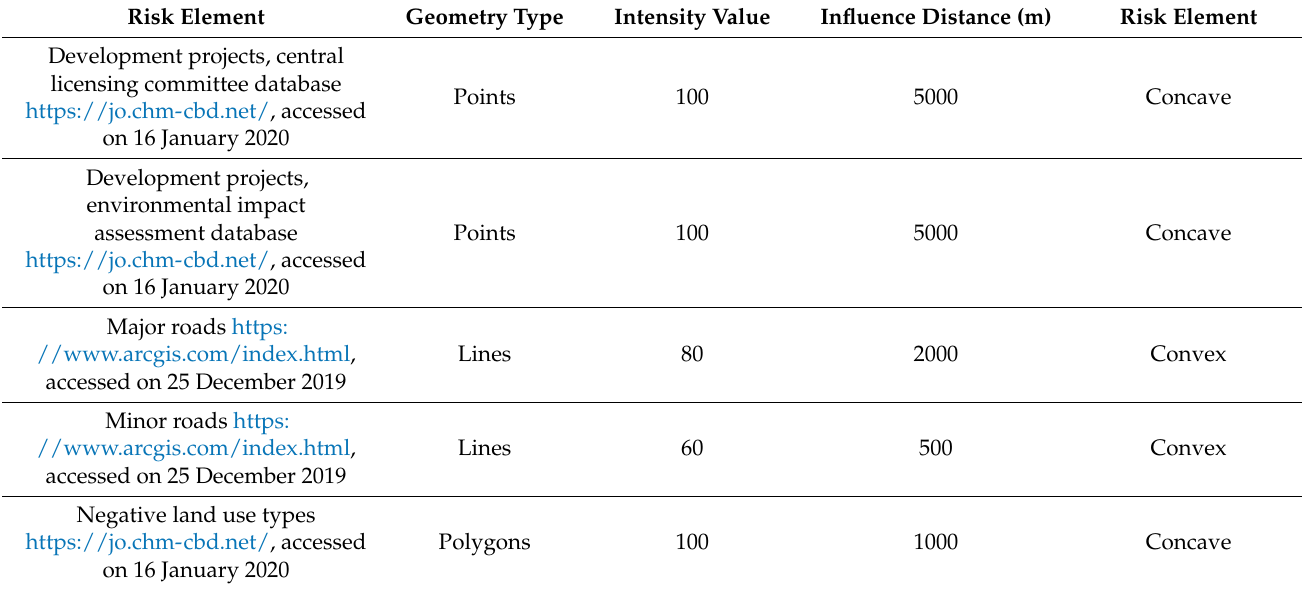
Table 2. Datasets used in producing ERS with corresponding parameters in this